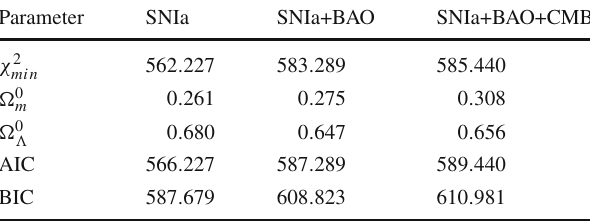
Table 2 Summary of the observational constraints for the free param- eters and for the model RRG + RGE (with three free parameters: (cid:9) 0 m , ν and b